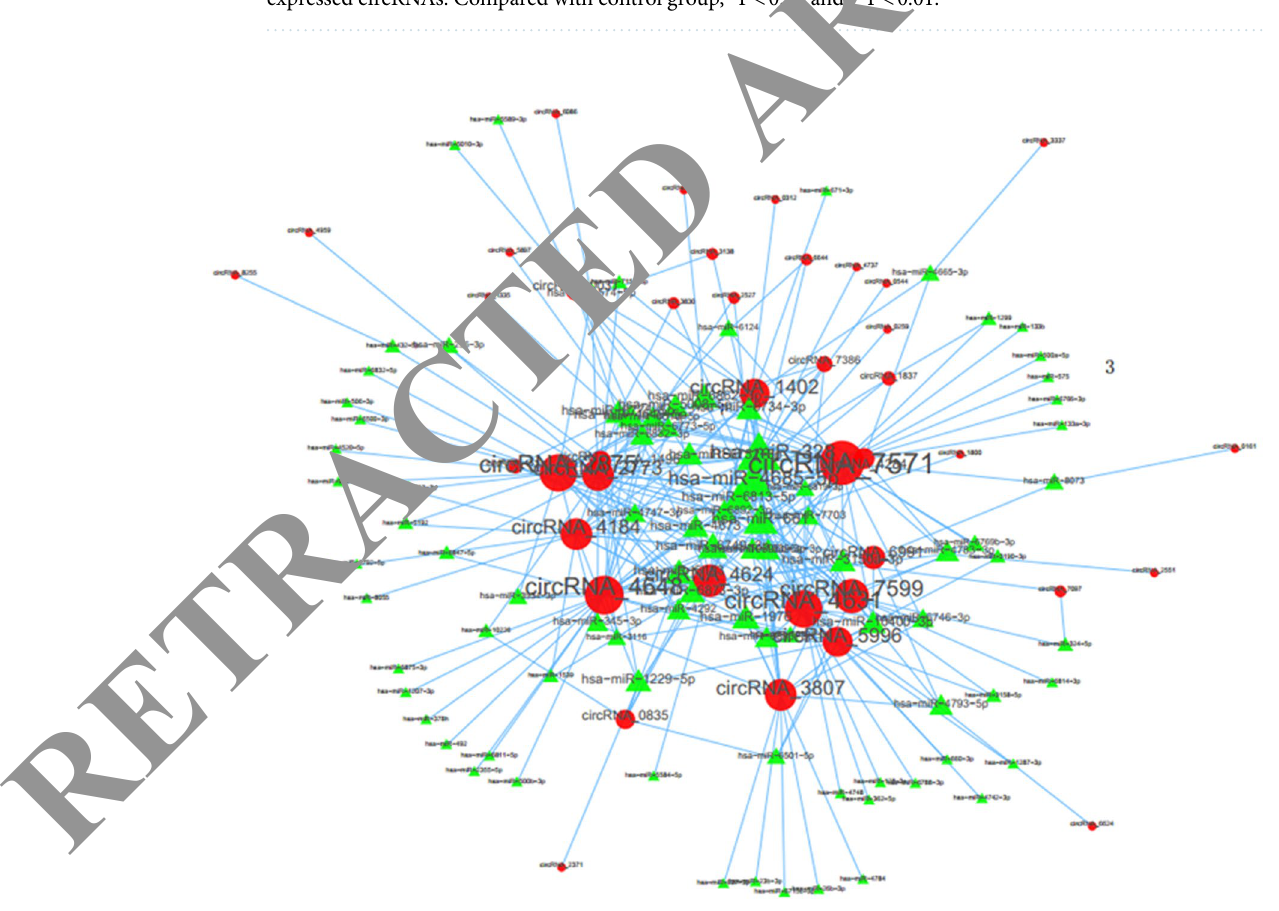
Figure 3. circRNA–miRNA coexpression network explored by using Cytoscape. The size of each node represents functional connectivity of each circRNA. The network consists of 37 circRNAs and 90 miRNAs. The red node represents circRNA and the green node represents miRNA. circRNA_7571, circRNA_4648, circRNA_4631 and circRNA_2875 were the four largest nodes in the network. hsa-miR-328 was the highest positive correlated miRNA in the